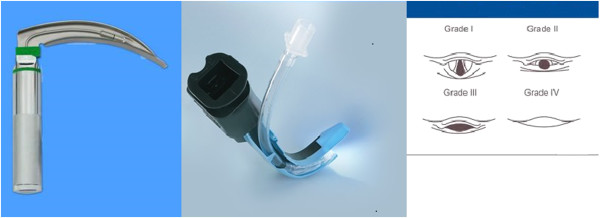
Two laryngoscopes and Cormack-Lehane classification of glottis exposure. Left is Macintosh laryngoscope, middle is Airtraq optical laryngoscope.